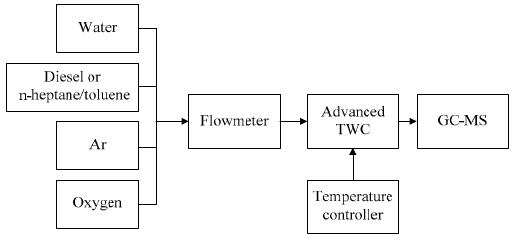
Figure 2. Schematic of reforming experimental setup.